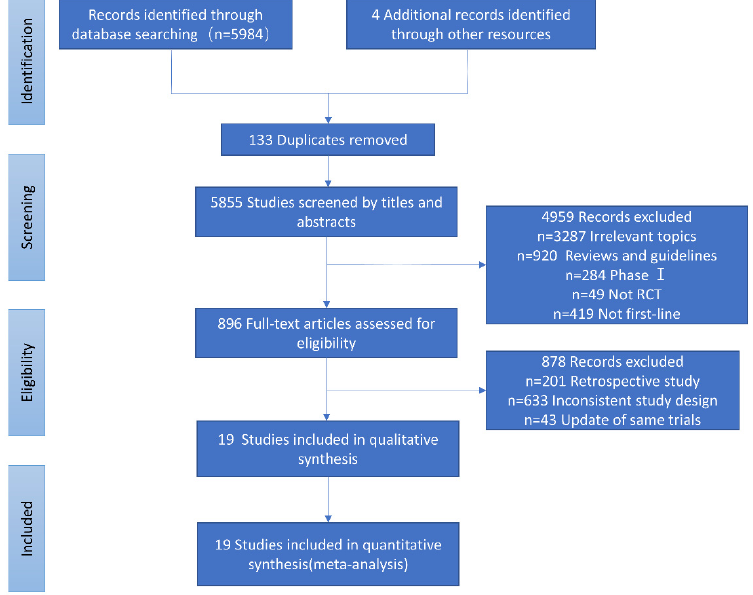
Figure 1. Flow-chart of the literature search.